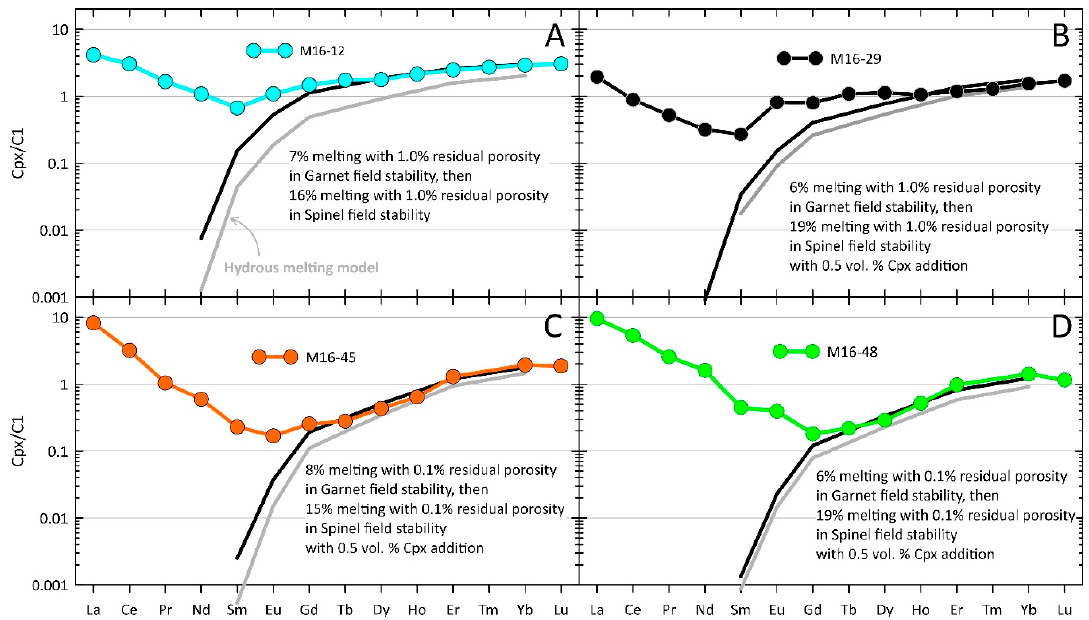
Figure 11. Modeling results of clinopyroxene composition for the polybaric continuous non-modal dynamic melting in the garnet, then in the spinel-peridotite facies. Composition of clinopyroxene1 from samples M16-12 ( A ), M16-29 ( B ), M16-45 ( C ), M16-48 ( D ) is shown for comparison. Black lines indicate anhydrous melting, and gray lines indicate hydrous melting. Equations for melting, polybaric model, and melting parameters (initial and melt modes, source composition, and mineral/melt partition coefficients) for anhydrous melting are from [60], and melting modes for hydrous melting are from [73]. See details in the text and Supplementary Table S3. Normalized to chondrite [52]. For the sample M16-11, we cannot simulate melting parameters for Cpx, since its HREE pattern does not correspond to the range of residual clinopyroxenes.